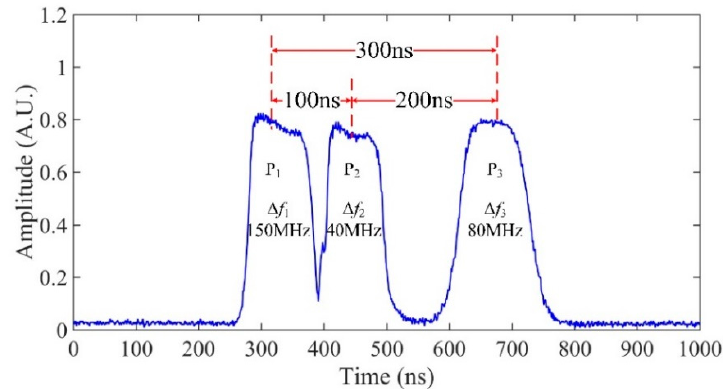
Figure 3. The time domain of three probe pulses.